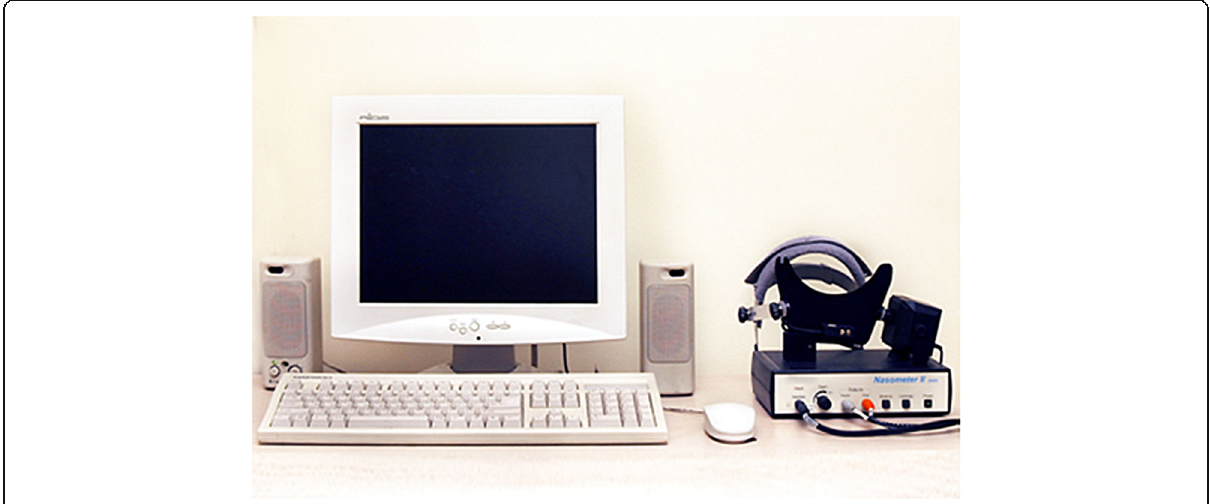
Fig. 1 Nasometer II, Model 6400 (KayPentax, USA, 2003)